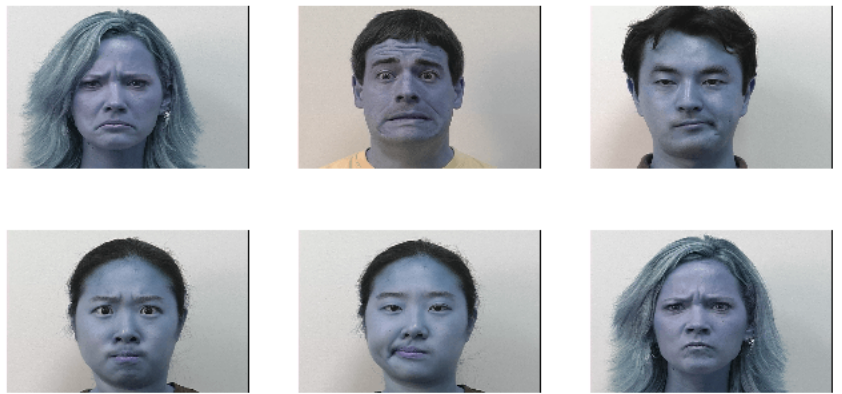
Figure 5. Six sample images from the CK+ database. JAFFE : This dataset contains 213 images of the 7 facial expressions posed by 10 Japanese female models. Each image has been rated on the six emotional adjectives by 60 Japanese subjects [15]. Four sample images from this dataset are shown in Figure 6.